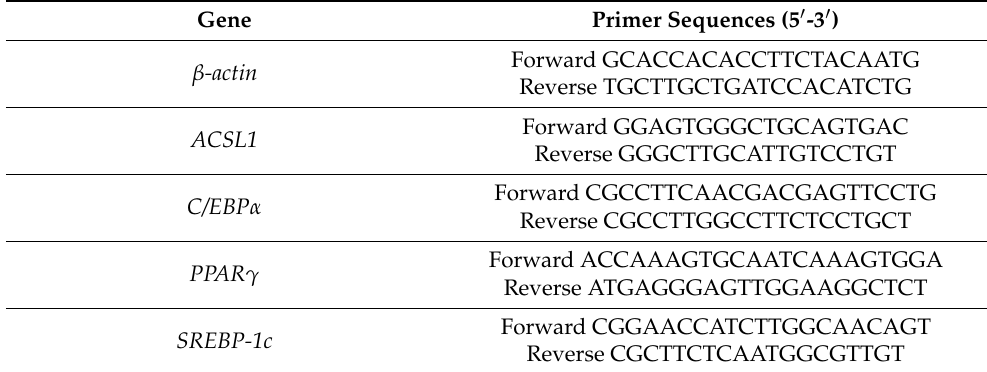
Table 2. Primer sequences used for RT (Reverse transcription)-PCR. Gene Primer Sequences (5 (cid:48) -3 (cid:48)